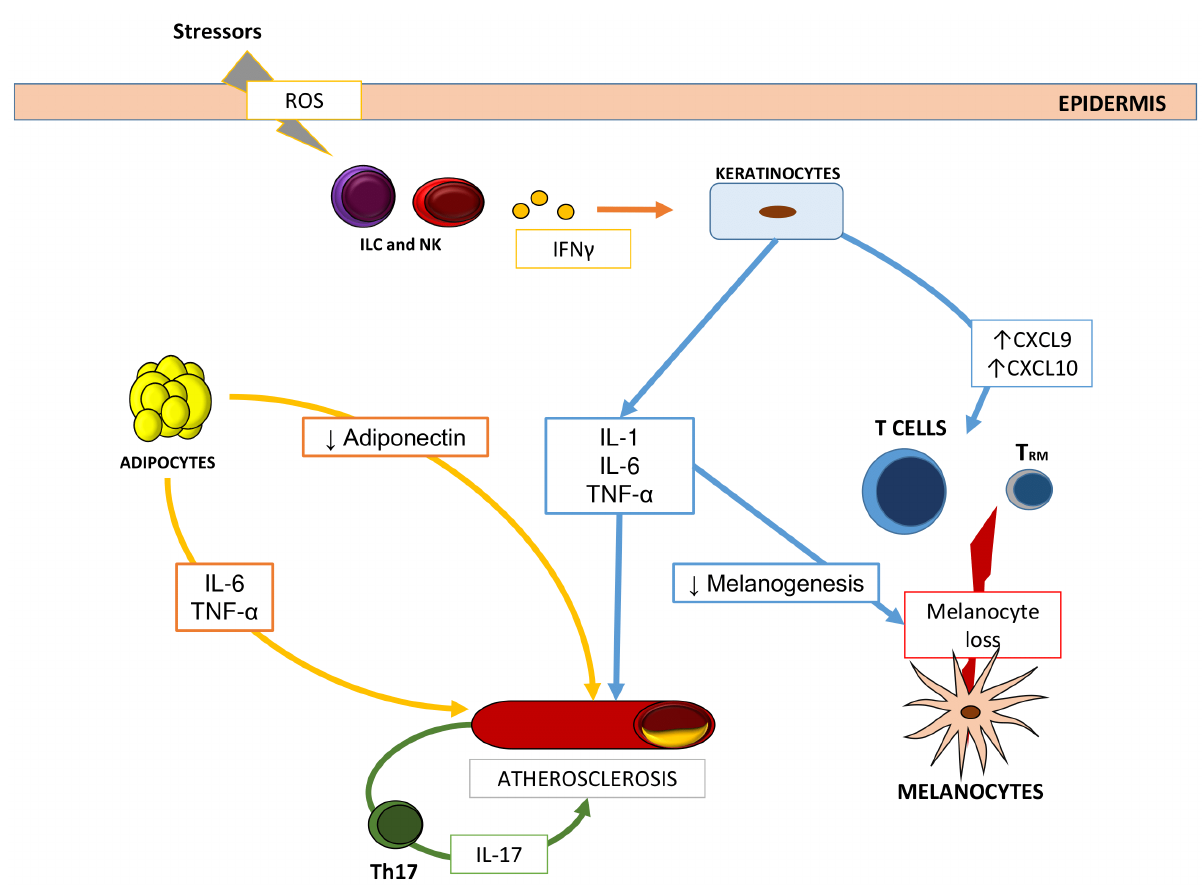
Figure 2. Proposed cross-relationship between vitiligo pathogenesis and metabolic syndrome manifestations, specifically atherosclerosis. Cytokines that play a role in vitiligo, such as IL-1, IL-6, and TNF- α , have been shown to induce accelerated